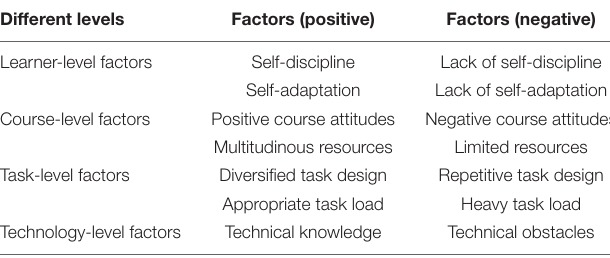
TABLE 1 | Coding scheme of factors influencing students’ SESRL in online